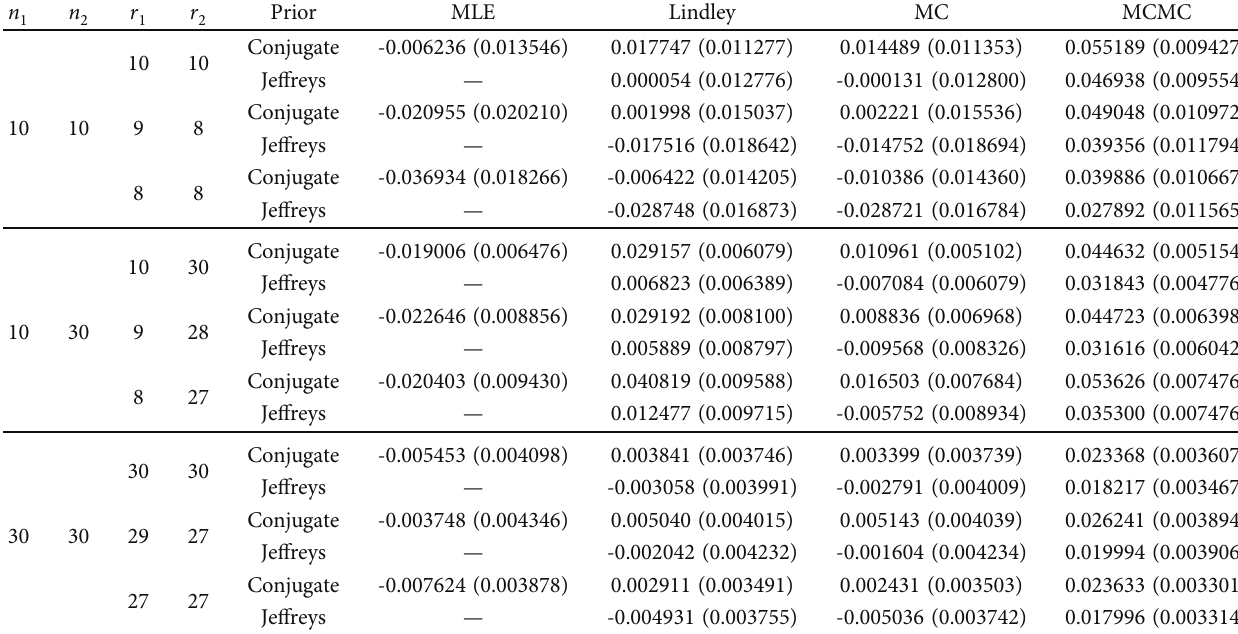
= 2, β = 1, γ = 1, R = 1/3 1 2